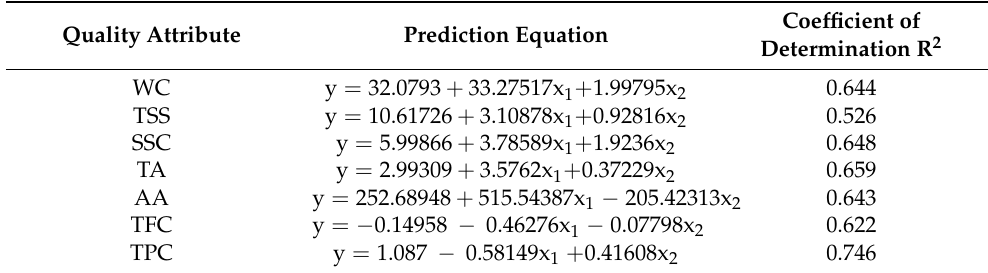
Table 2. Correlations between seven quality attributes and dielectric parameters of sea buckthorn fruit during freezing. Quality Attribute